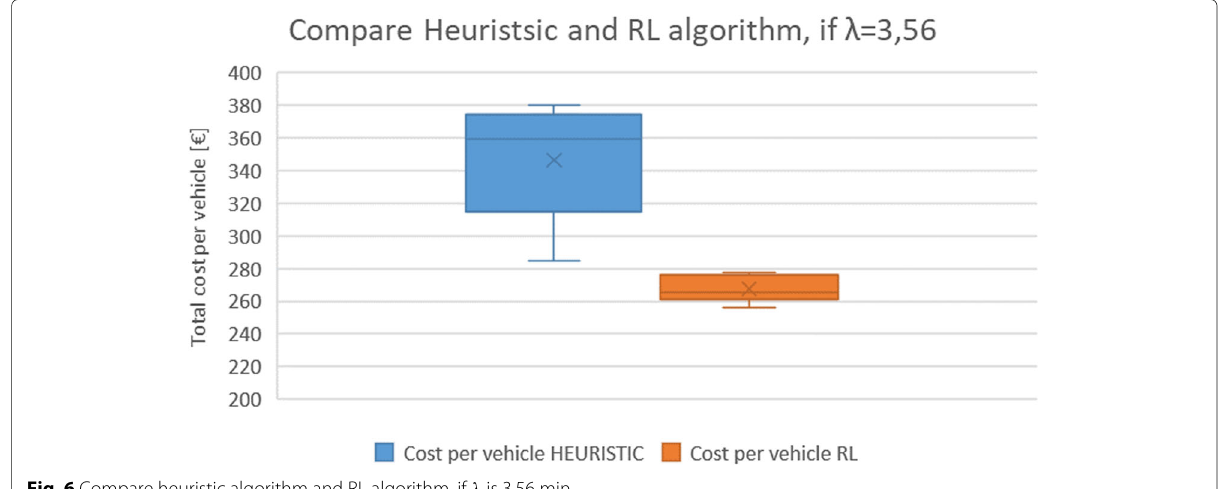
Fig. 6 Compare heuristic algorithm and RL algorithm, if λ is 3,56